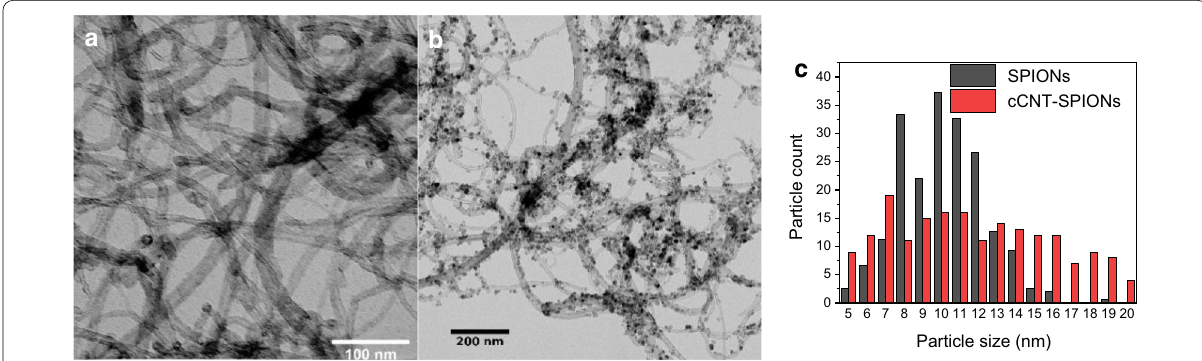
Fig. 1 TEM images of cCNTs ( a ) and cCNT‑SPIONs ( b ). Size distribution from four images and a count of minimum 30 particles per picture for each material